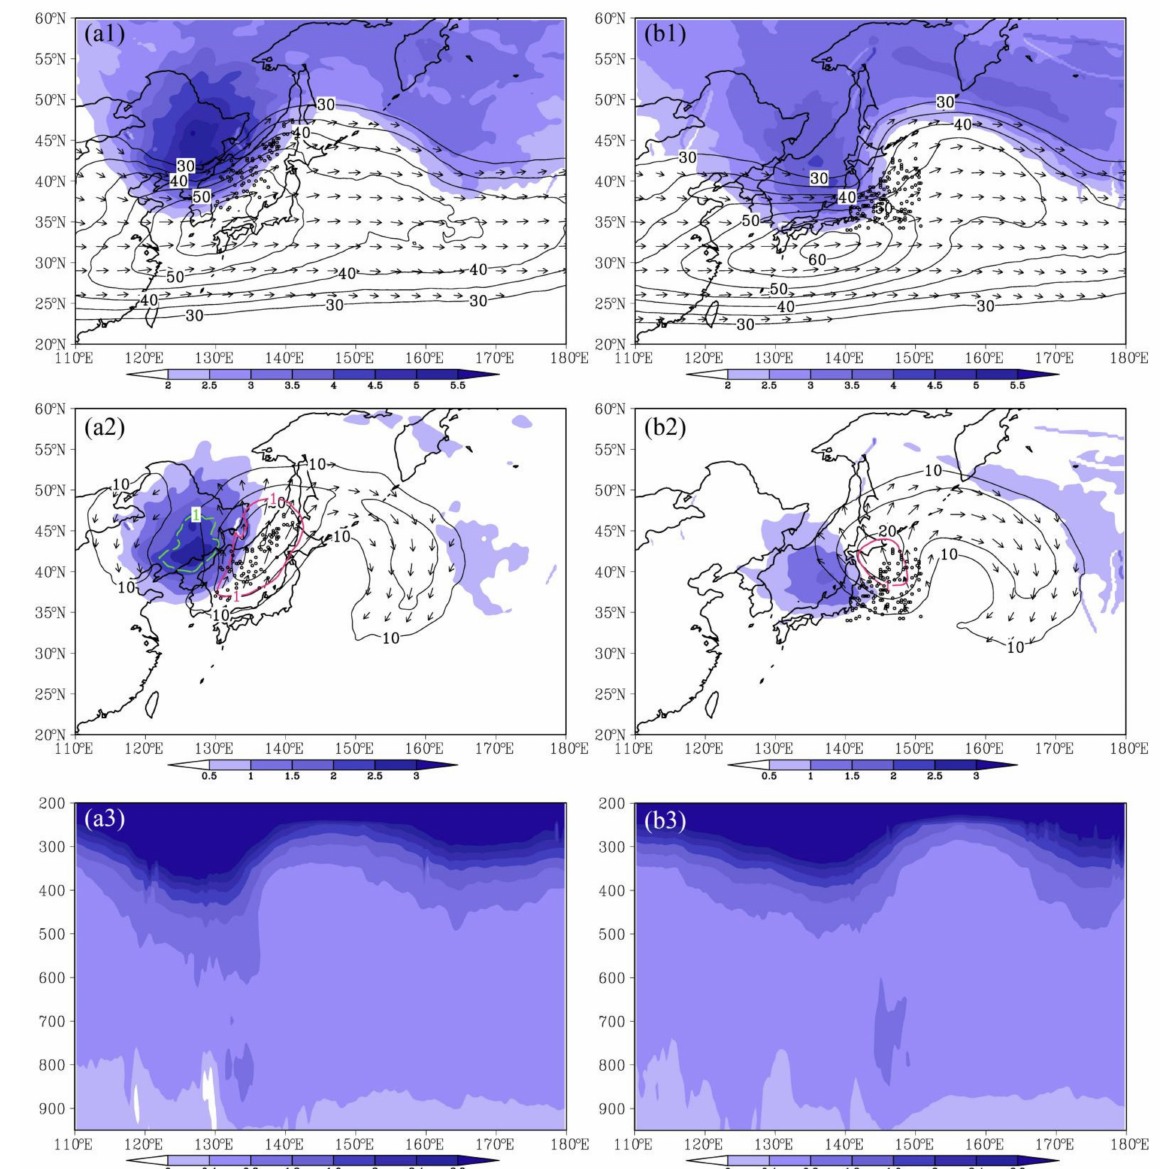
Figure 13. Composite fields of 300 hPa jet stream (solid line, 5 m s − 1 intervals), horizontal wind vector (arrow, ≥ 30 m s − 1 ) and PV (shaded, 0.5 PVU intervals) for ECs at maximum-deepening-rate moment over ( a1 ) the Japan Sea and ( b1 ) Kuroshio/Kuroshio Extension. The corresponding anomaly fields are in ( a2 , b2 ), The red and green lines indicate the RAS of geopotential height and relative vorticity equal to 1 or − 1. Note the horizontal wind vector is ≥ 10 m s − 1 . ( a3 , b3 ) are vertical cross sections of compos- ite PV (0.4 PVU intervals) along 42 ◦ N and 40 ◦ N for ECs over the Japan Sea and Kuroshio/Kuroshio Extension, respectively. “ ◦ ” is the EC center at the maximum-deepening-rate